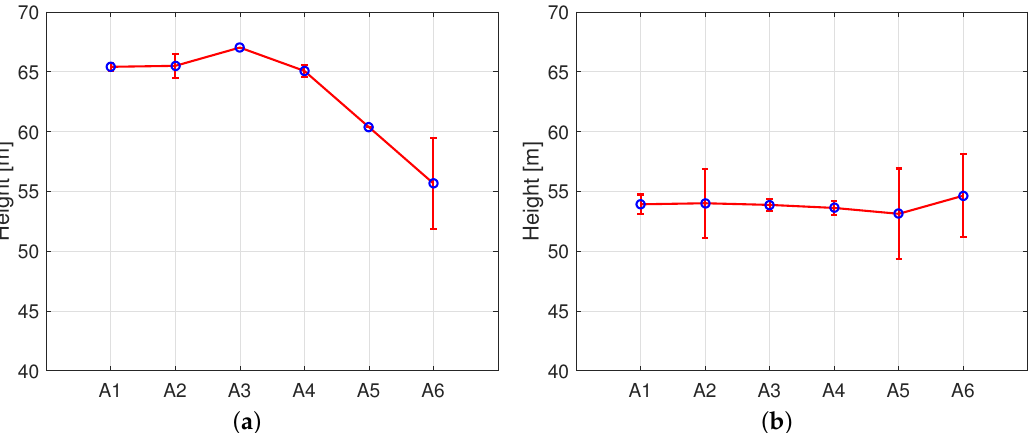
Figure 11. The mean height scatterplot with std bars of bridge roofs A 1 , A 2 , A 3 , A 4 , A 5 , and A 6 marked in Figure 3: ( a ) StaMPS; and ( b ) IStaMPS.